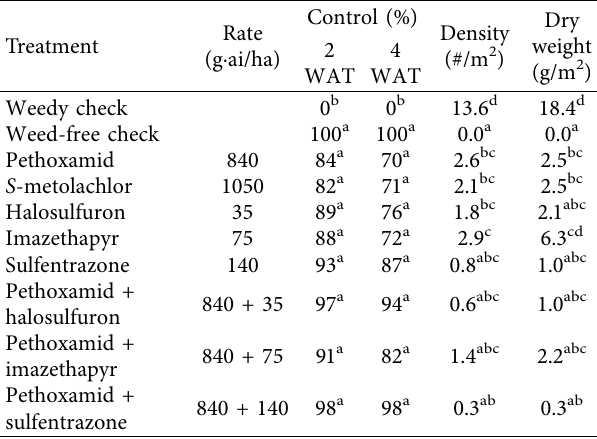
Table 2: Percent control, density, and dry weight of redroot pigweed pigweed 2 and 4 weeks after herbicide treatment (WAT) in white bean treated with pethoxamid applied PRE in 2015, 2016, and